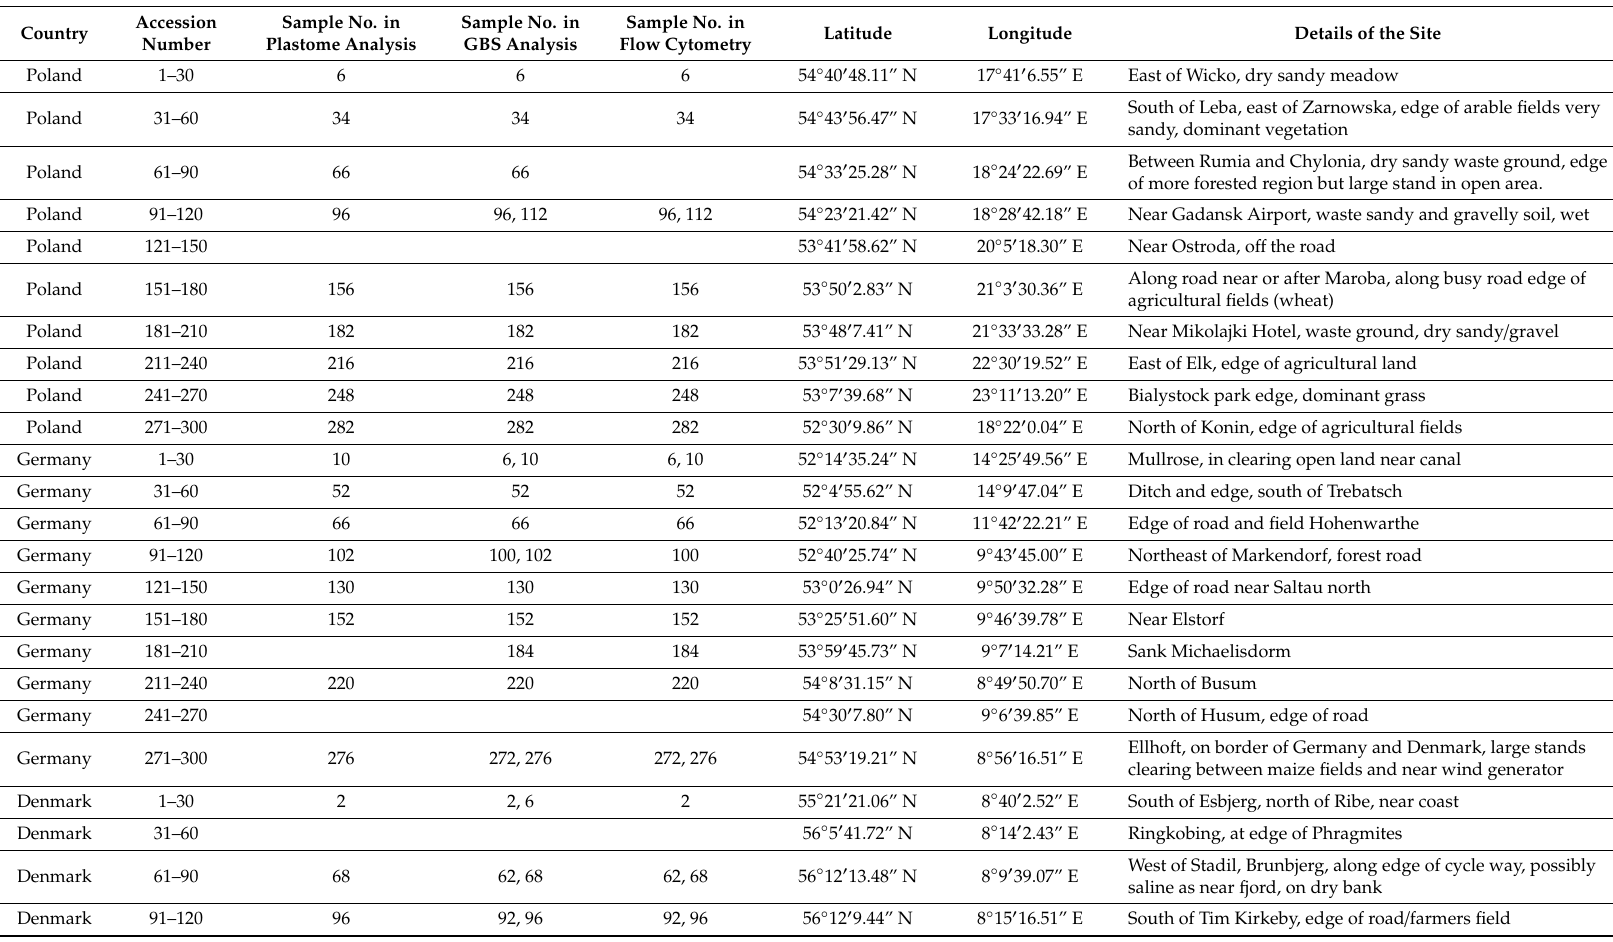
Table 1. Dactylis glomerata collected for ex-situ conservation and used in the